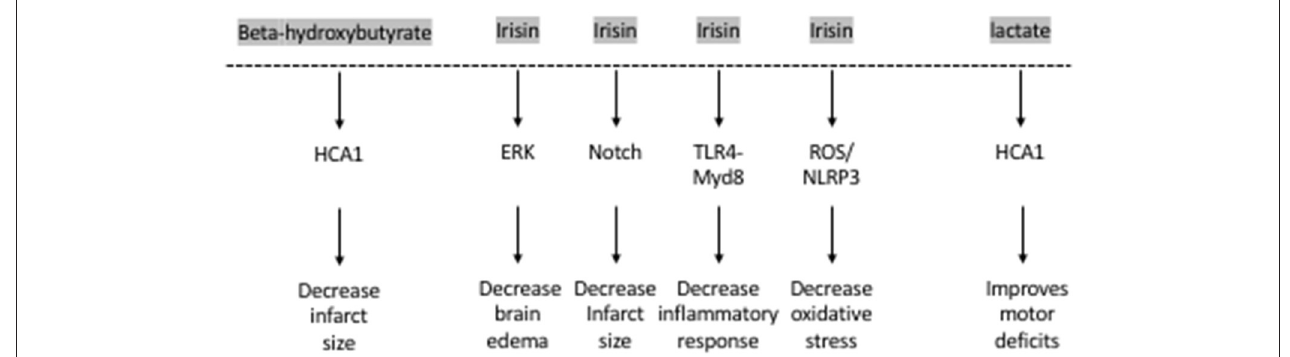
FIGURE 2 | The exercise factors, beta-hydroxybutyrate, irisin and lactate protect against ischemic stroke.